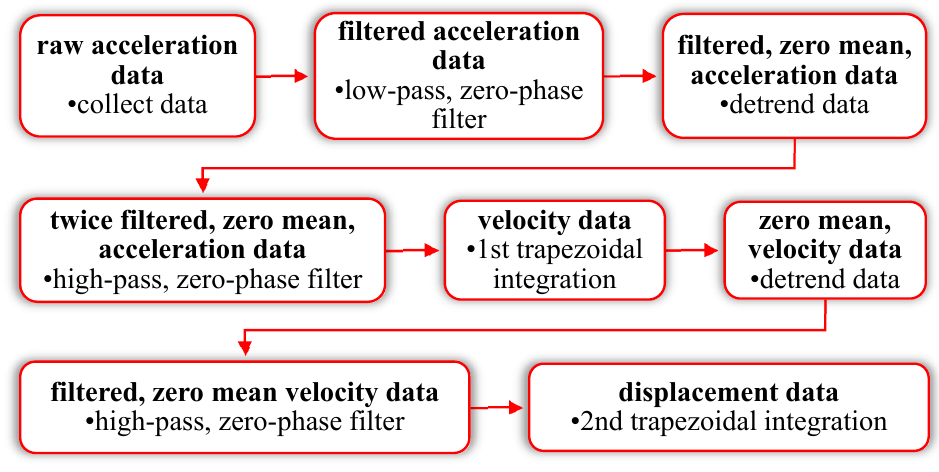
Figure 9. Data integration procedure.